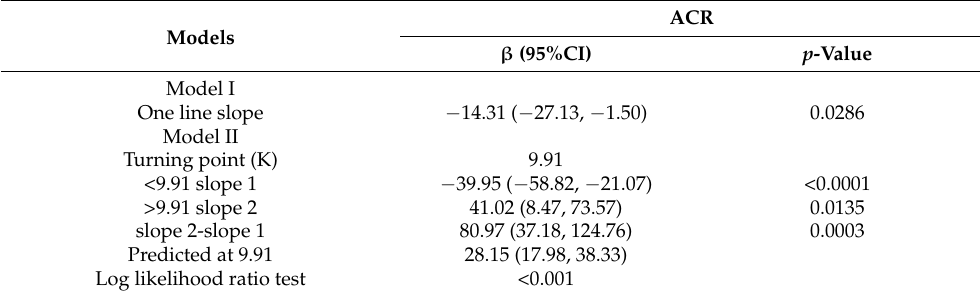
Table 4. Threshold effect analysis of α -Klotho on ACR using the two-piecewise linear regression